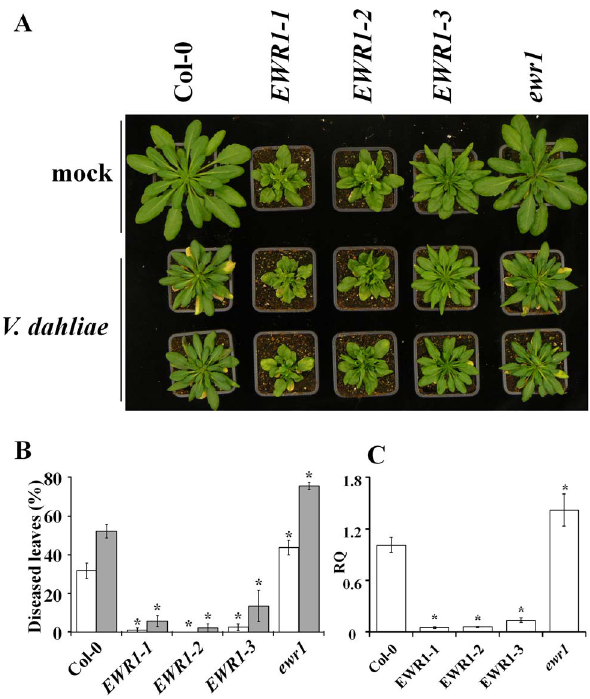
Figure 3. EWR1 over-expressing Arabidopsis plants are resis- tant to V.dahliae . (A) Typical symptoms of V. dahliae on the wild-type (Col-0), three EWR1 expressing lines (EWR1-1, EWR1-2, and EWR1-3) and EWR1 knock out line ( ewr1 ). Picture was taken at 21 days post inoculation and a representative of three experimental replicates is shown. (B) Disease severity score for the wild-type (Col-0), the three EWR1 expressing lines (EWR1-1, EWR1-2, and EWR1-3) and EWR1 knock out line ( ewr1 ) at 14 (white bar) and 21 (grey bar) days post inoculation (dpi). The total number of rosette leaves and the number of rosette leaves that showed Verticillium symptoms were counted at least from eight plants and percentage of the diseased leaves were calculated as an indication of disease severity. The bars represent the average of three independent experiments with standard deviation and asterisks indicate significance differences (Dunnett t-test at P=0.05 ). (C) Relative quantification (RQ) by real-time PCR of Verticillium colonization by comparing levels of the V. dahliae internal transcribed spacer (ITS) region of the ribosomal DNA (as measure for fungal biomass) relative to levels of the large subunit of the Arabidopsis RubisCo gene (for equilibration) at 21 dpi. Bars represent averages with standard deviation of four technical replicates. A representative of three independent experiments is shown. doi:10.1371/journal.pone.0088230.g003 EWR1 - 2 ), along with the wild-type Col-0 and the ewr1 mutant with R. solanacearum strain GMI1000. While Col-0 plants showed mild disease symptoms at 3 dpi which aggravated by 6 dpi (Figure 4 A, B), resulting in death of the inoculated plants by 10 dpi, most rosette leaves of GMI1000-inoculated ewr1 plants showed clear wilting at 3 dpi and completely collapsed by 6 dpi, indicating that ewr1 plants show enhanced susceptibility to R. solanacearum . Conversely, EWR1 over-expressing plants were completely resis- tant to R. solanacearum and did not show any disease symptoms throughout the assay up to 10 dpi (Figure 4A, B). With real-time PCR it was confirmed that the amount of disease symptoms observed on the various genotypes correlates with the degree of R. solanacearum colonization (Figure 4C). Hardly any bacterial DNA was detected in DNA extracts of EWR1 - 1 and EWR1 - 2 rosette leaves, indicating that EWR1 over-expression provides a high level of R. solanacearum resistance.